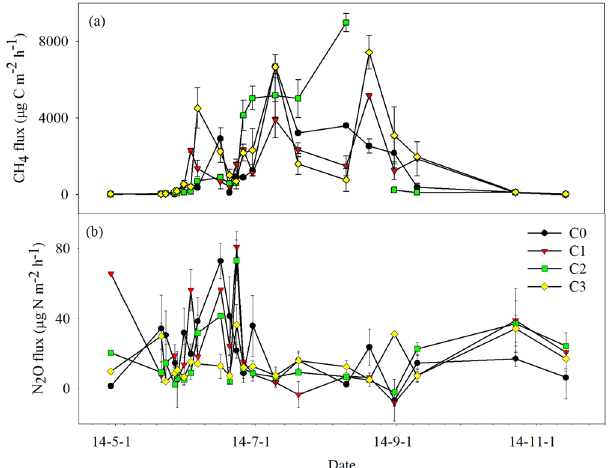
Figure 3. Variation of CH 4 ( a ) and N 2 O ( b ) fluxes under the four experimental treatments. Data are shown as means with standard errors.